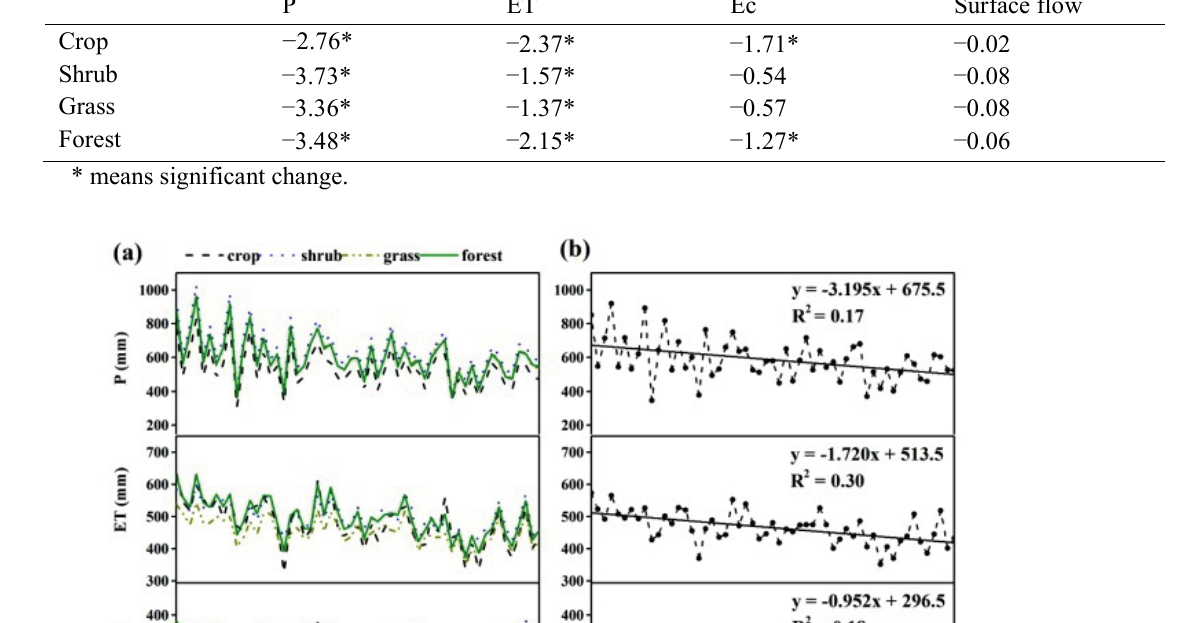
Table 1 Linear trends of water budget (mm/year) for each vegetation type. P ET Ec Surface flow Crop − 2.76* − 2.37* − 1.71* − 0.02 Shrub − 3.73* − 1.57* − 0.54 − 0.08 Grass − 3.36* − 1.37* − 0.57 − 0.08 Forest − 3.48* − 2.15* − 1.27* − 0.06